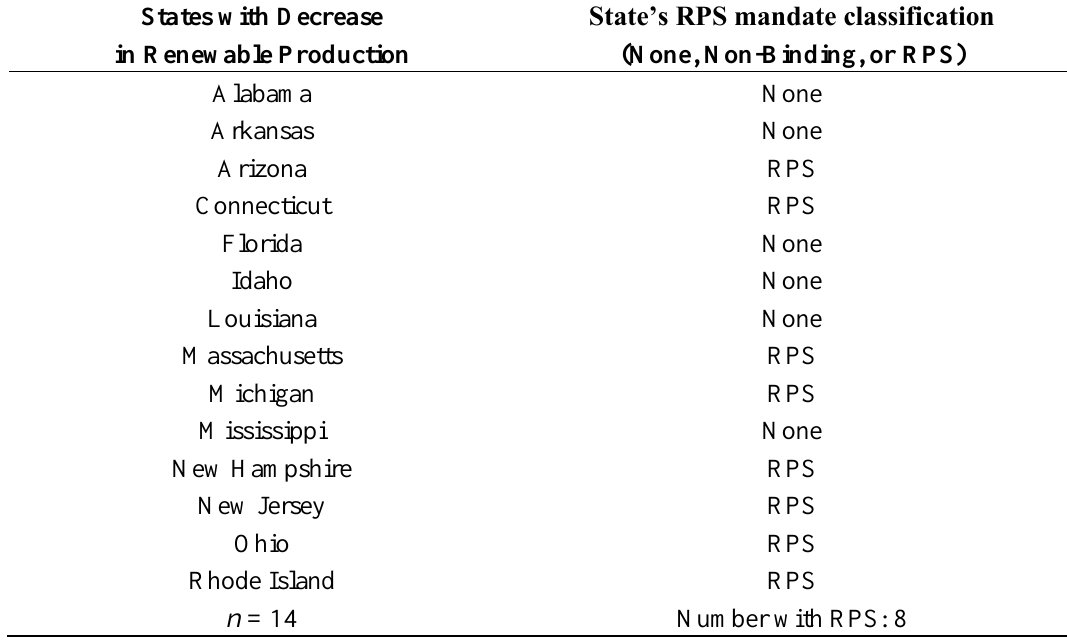
Table 4. State RPS mandates in states with decreased * percentage of renewable energy generation contributing to overall energy generation.